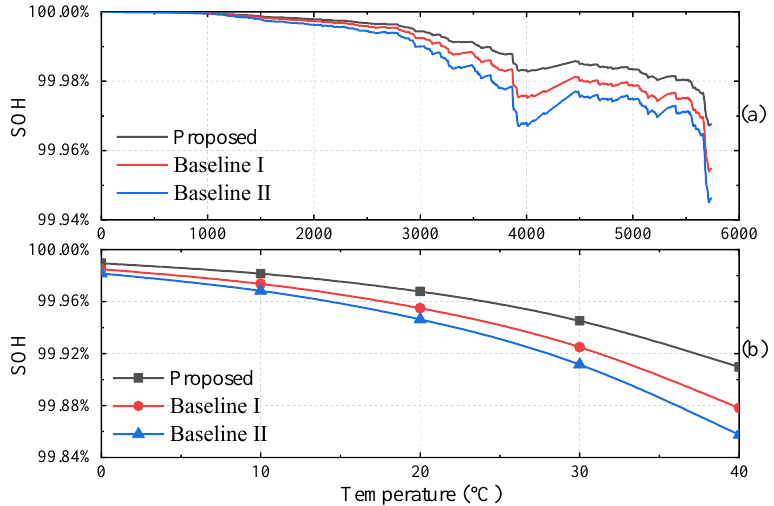
Figure 9. ( a ) SOH degradation rate with respect to different strategies; ( b ) SOH degradation rate with respect to different ambient temperatures.